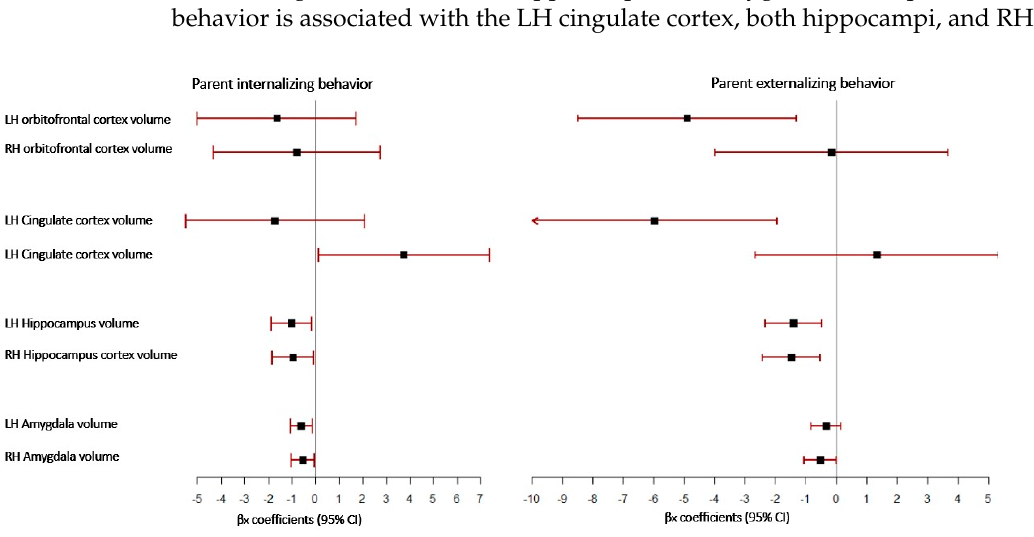
Figure 3. Associations between parental behavior and children limbic brain structures volume (mm 3 ) using forest plot.